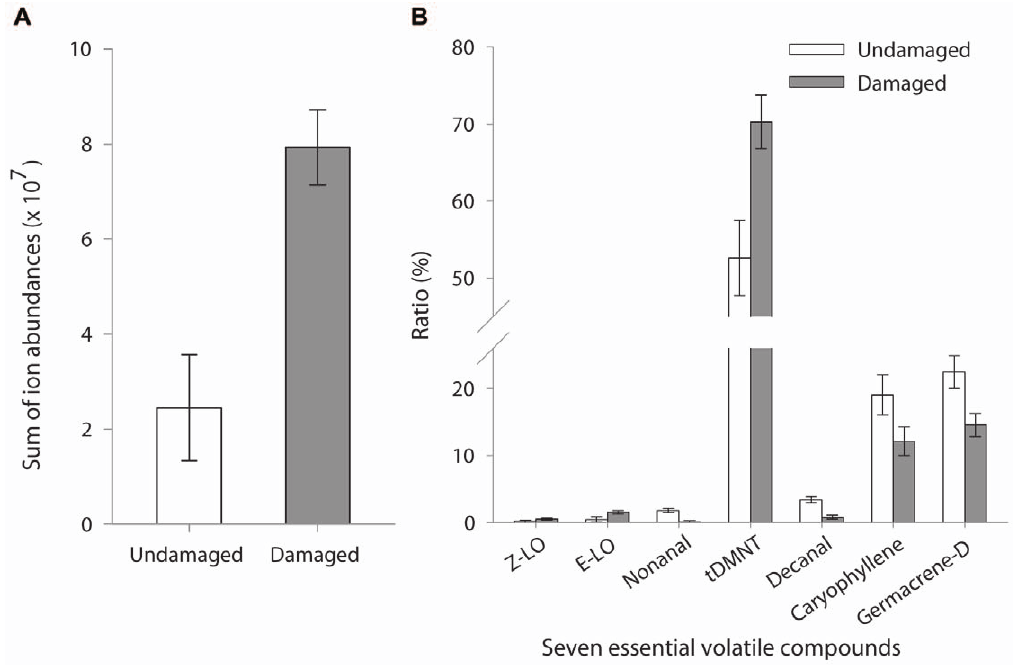
Figure 3. GC-MS analysis of headspace volatiles from Japanese beetle damaged vs undamaged grapevines. Modulation in the (A) concentration (as the sum of ion abundances from GC/MS analyses 6 SE ) and (b) ratio (% 6 1 SE ) of the 7 key volatile compounds emitted from Japanese beetle damaged vs. undamaged V. riparia shoots ( N =8). Z-LO: ( Z )-linalool oxide; E-LO: ( E )-linalool oxide; tDMNT: 4,8-dimethyl-1,3( E ), 7-nonatriene.